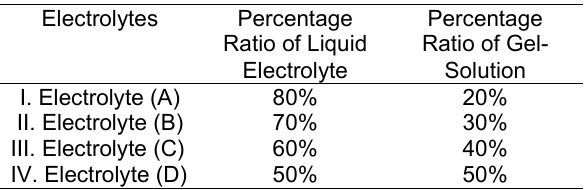
Table 1. Final quasi solid-state electrolyte solutions Electrolytes